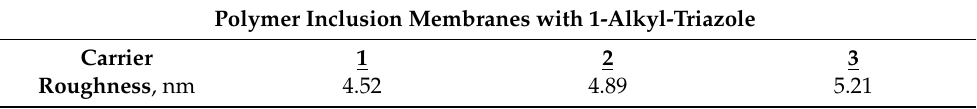
Table 2. The average roughness for PIM with 1-alkyltriazole; 1 –1-hexyltriazole, 2